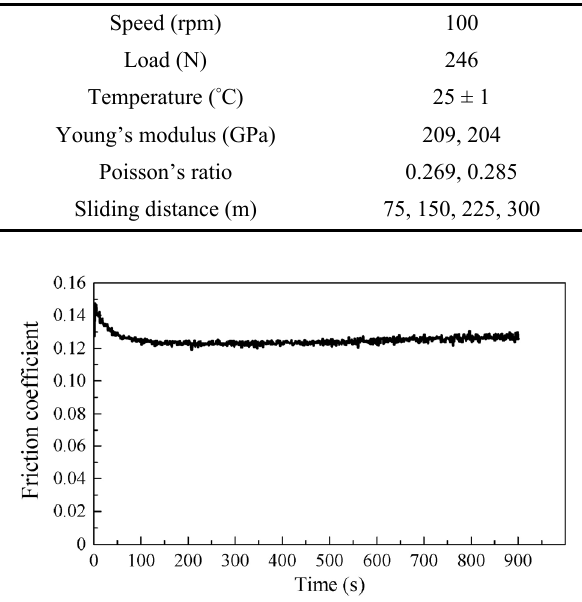
Fig. 5 Diagram of wear width mapping.